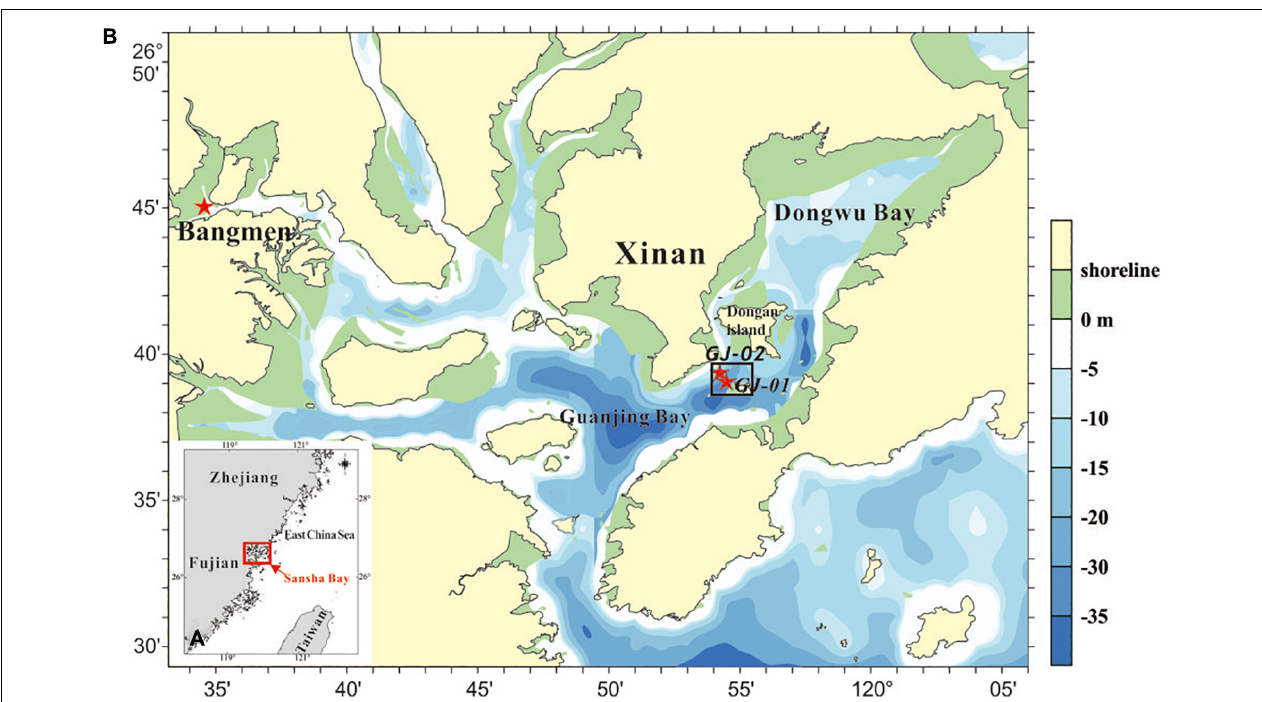
FIGURE 1 | (A) Location of the Sansha Bay in the East China Sea and (B) Bathymetric map of the Sansha Bay with the tide-gauging station at Bangmen and the two campaigning sites: GJ-01 (inside the cage farm) and GJ-02 (outside the farm). The red stars indicate the locations of observation sites.